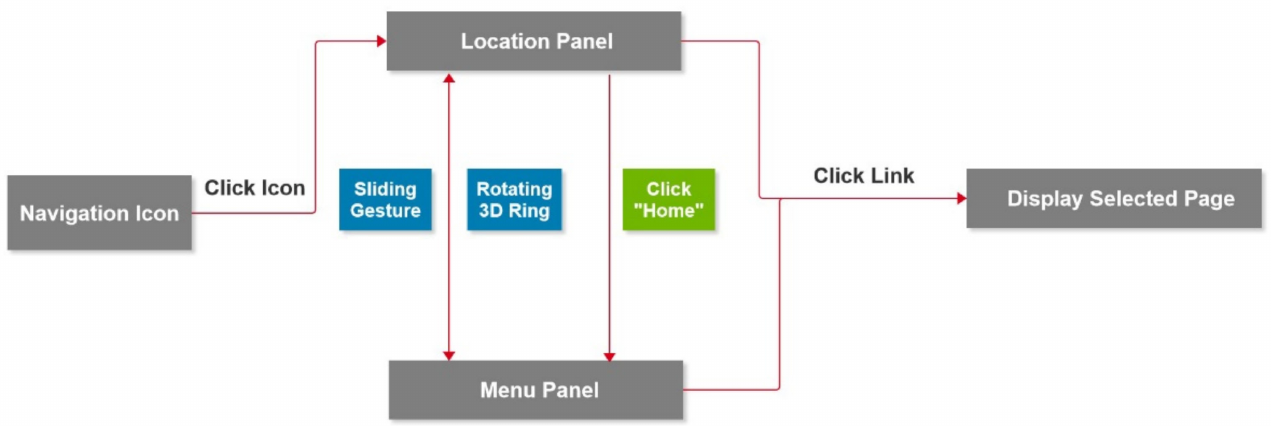
Figure 10. Navigation interaction flow